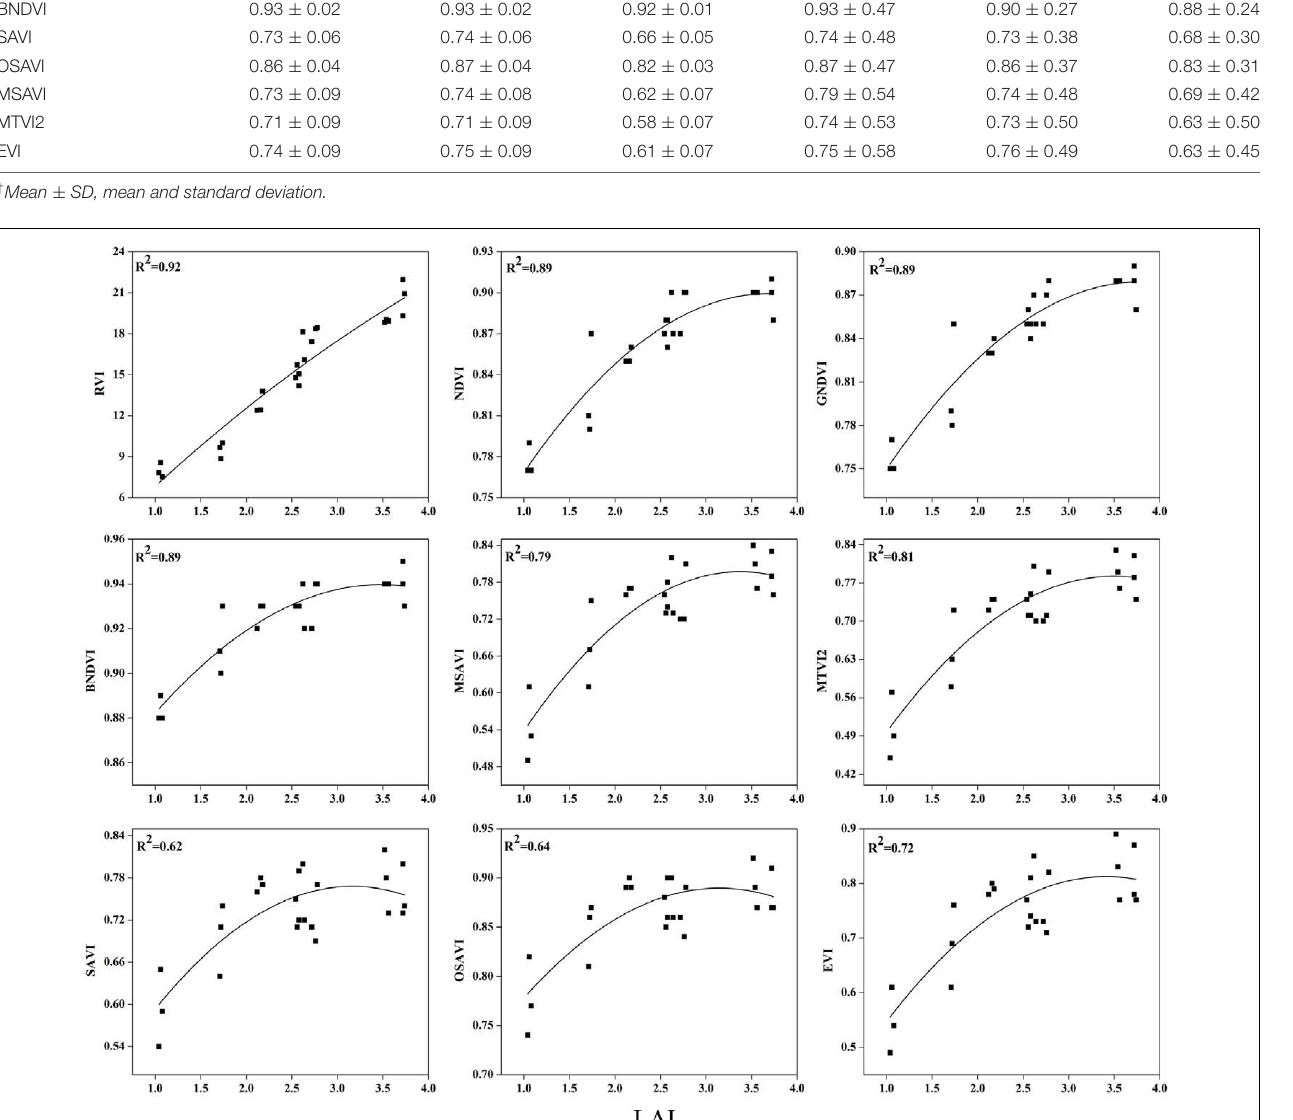
demonstrated a significant change in the absorption of the red and green regions and reflectance in the NIR region due to changes in the leaf area over the growth period.